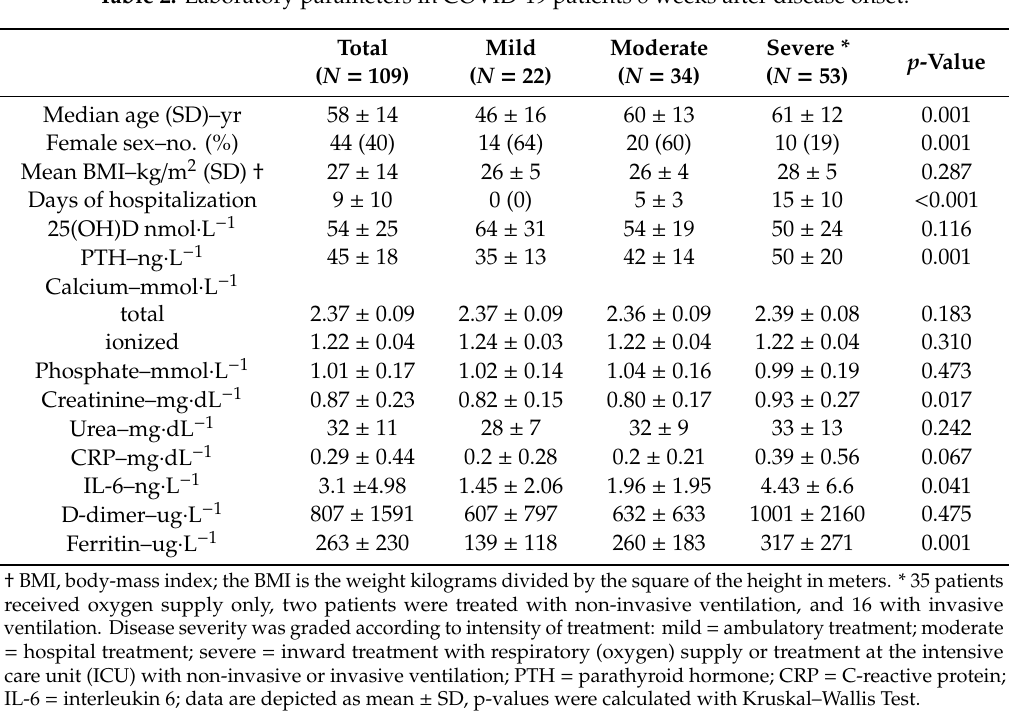
Table 2. Laboratory parameters in COVID-19 patients 8 weeks after disease